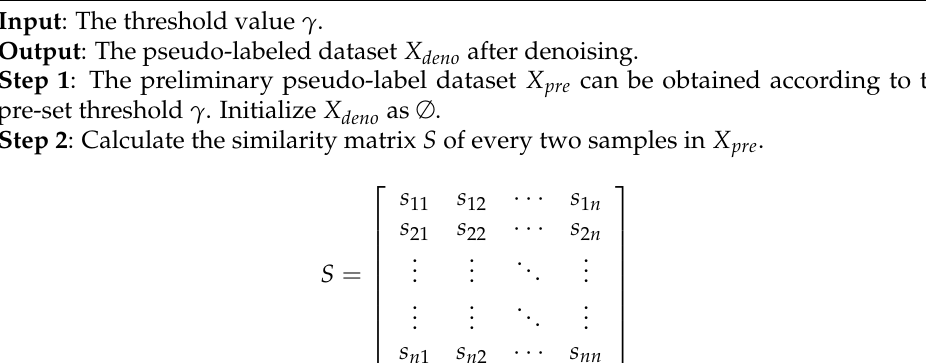
Algorithm 1 Pseudo-label denoising method